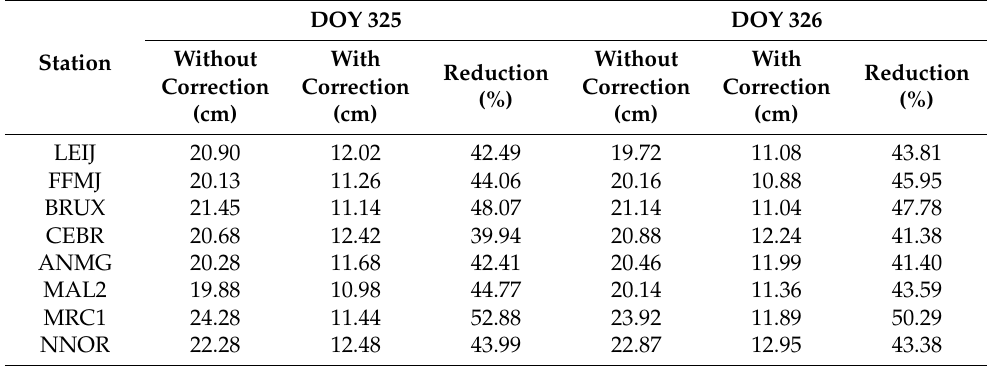
Table 2. The STDs of the code pseudorange variations without and with correction at LEIJ, FFMJ, BRUX, CEBR, ANMG, NNOR, MAL2, and MRC1 stations. DOY 325 DOY 326